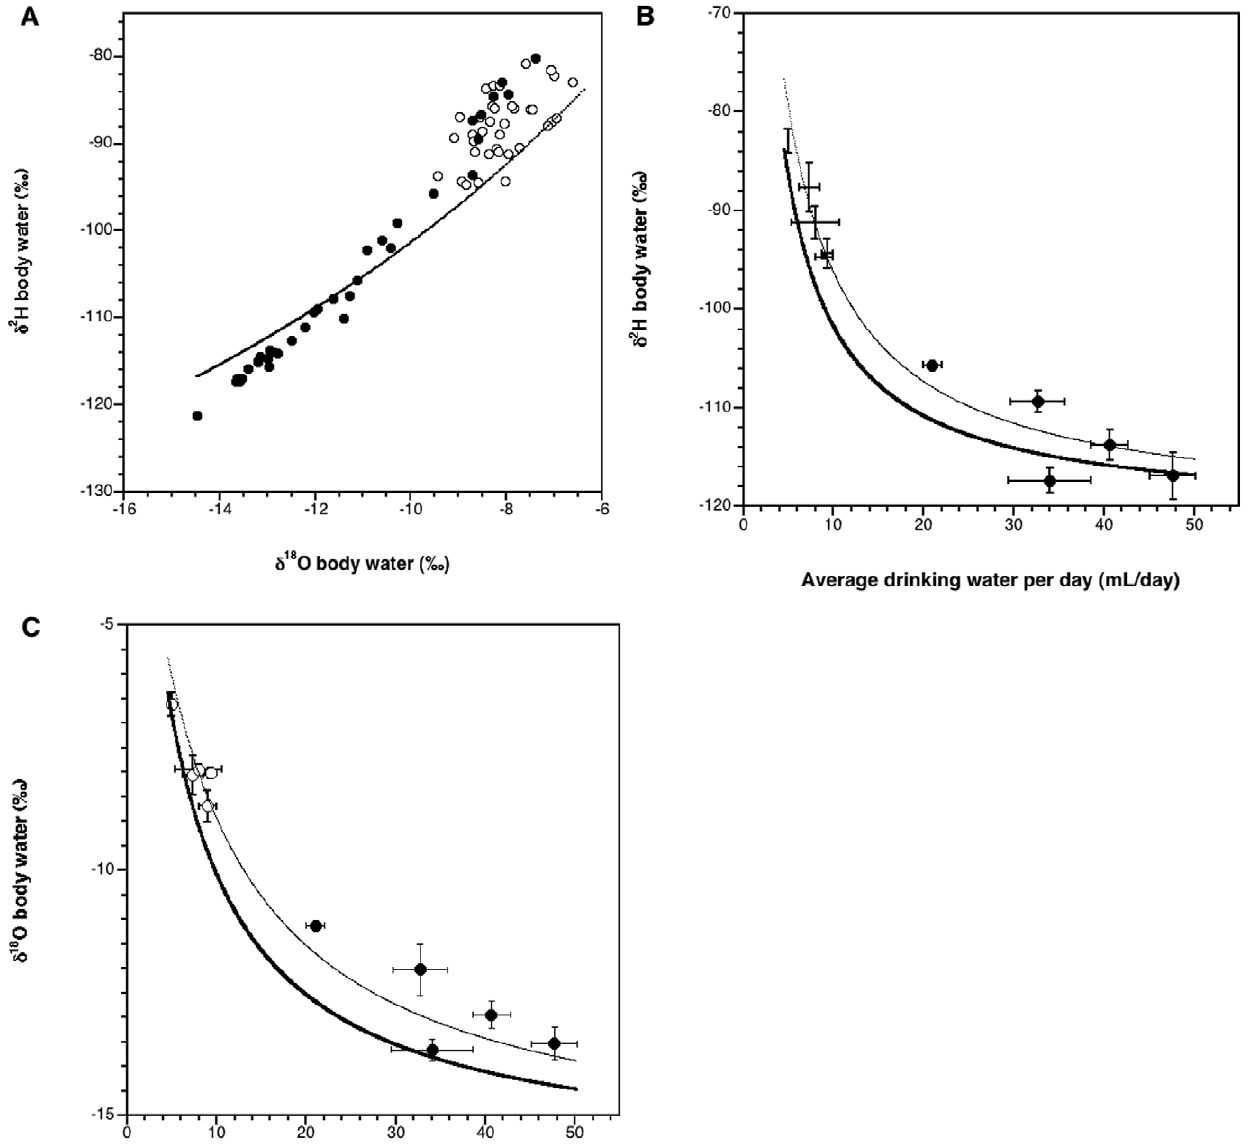
N ) mice relative